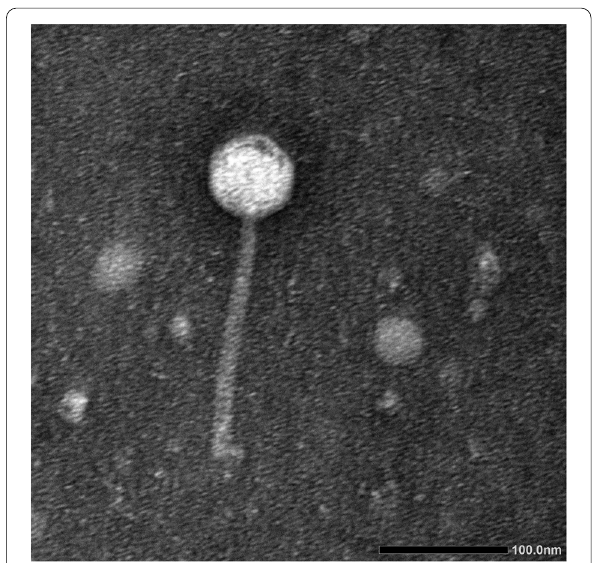
Fig. 1 Transmission electron microscopic image of phage